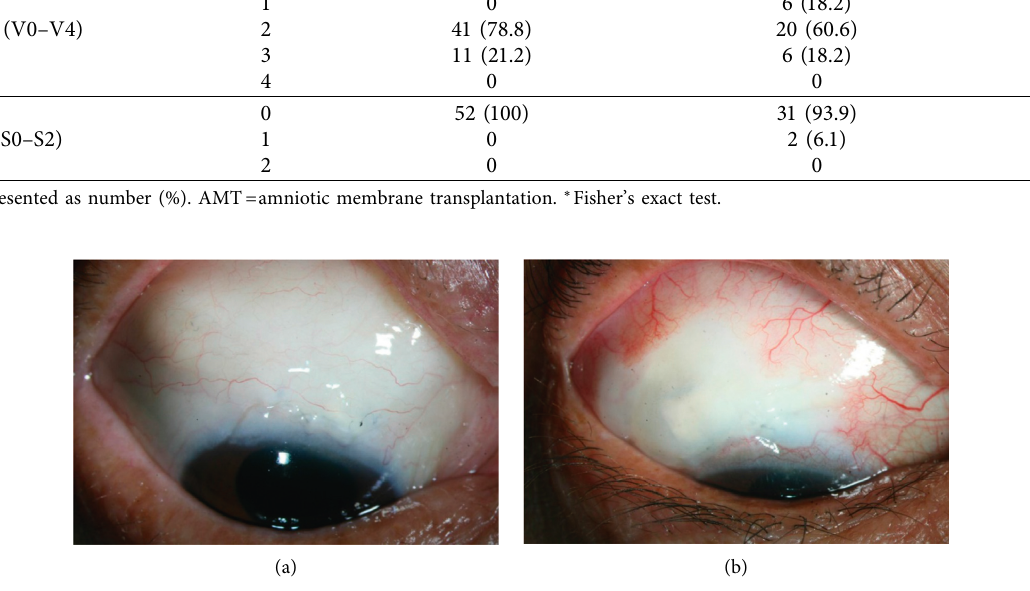
Figure 4: Slit-lamp photograph of the filtering bleb. (a) Bleb photograph taken 4 years after trabeculectomy with AMTshowed a bleb with medium height, 4-clock hour extent, and mild vascularity. Intraocular pressure (IOP) was 13mmHg without medication. (b) Bleb photograph taken 5 years after trabeculectomy without AMT showed medium height, 3-clock hour extent, and avascular cystic bleb. IOP was 16 mmHg without medication.